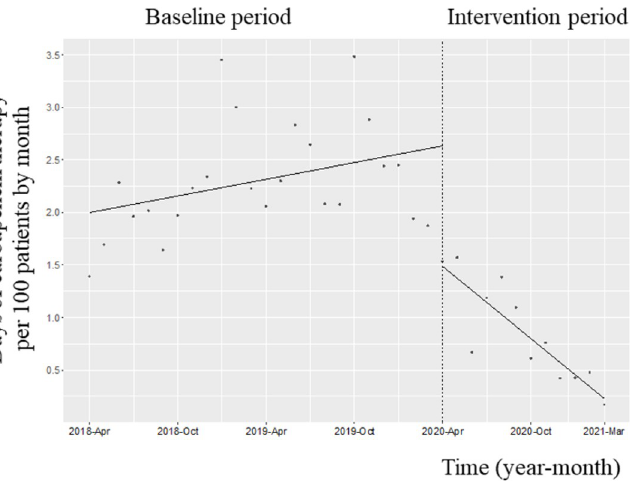
Fig 1. Trends in the days of carbapenem therapy per 100 patients, by month, during Phase 2 of the intervention period. Each dot refers to the days of carbapenem therapy per 100 patients in each month, and the slope is based